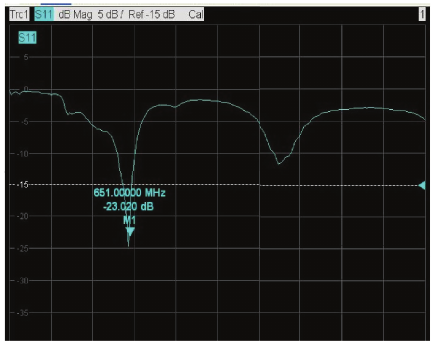
Figure 14: Antenna gain measurement